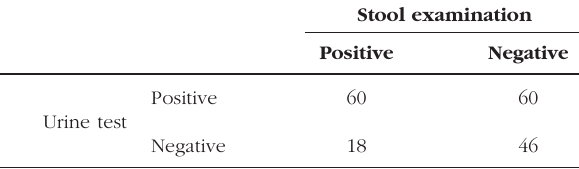
Table II. – Comparison of urine test with stool examination methods in the diagnosis of schistosomiasis mansoni. I NTENSITY OF INFECTION Of the total 67 positive subjects by Kato, 47 (70.1 %), 17 (25.4 %) and 3 (4.5 %) were found to have light, moderate and heavy infections, respectively. Among individuals with light infection, 10 (21.3 %), 31 (66 %)